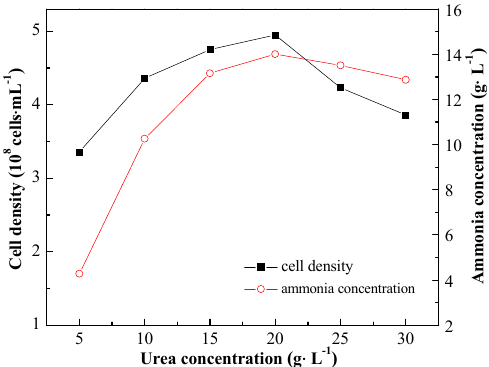
Figure 4. Effect of urea concentration on strain growth and ammonia production. Ammonia production was determined by the concentration of ammonia in culture solution. The data were measured at the stationary phase of strain.